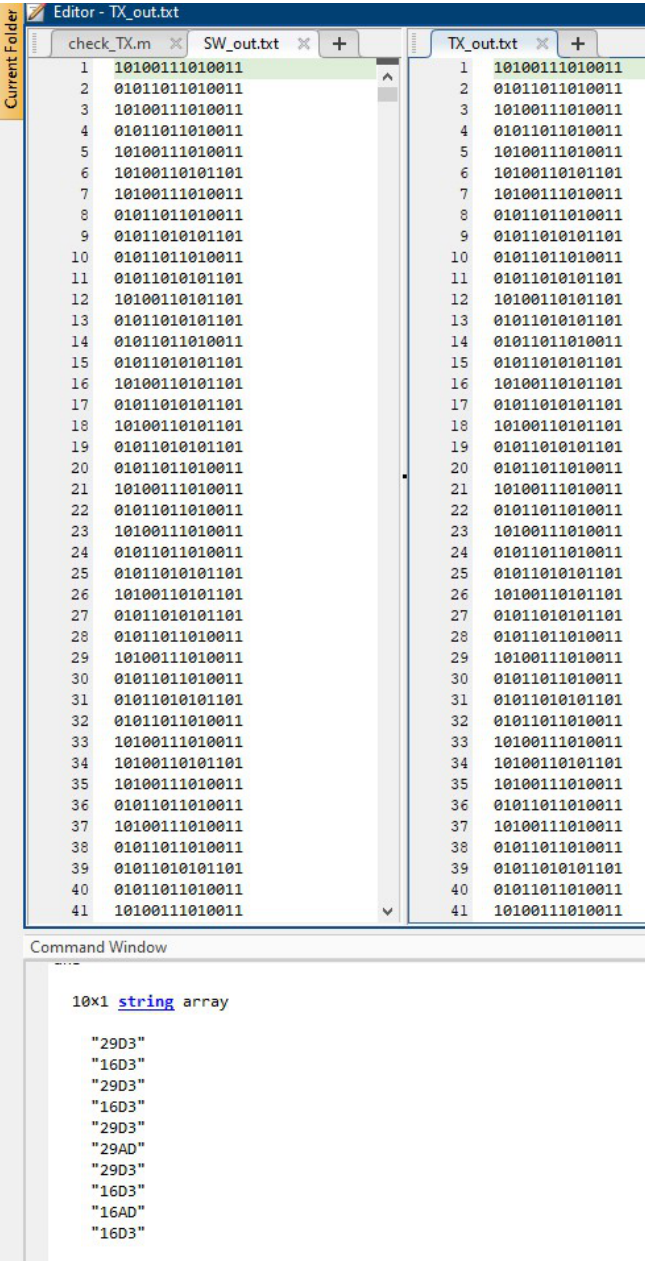
Figure 20. MATLAB output for the first 41 symbols of a PL